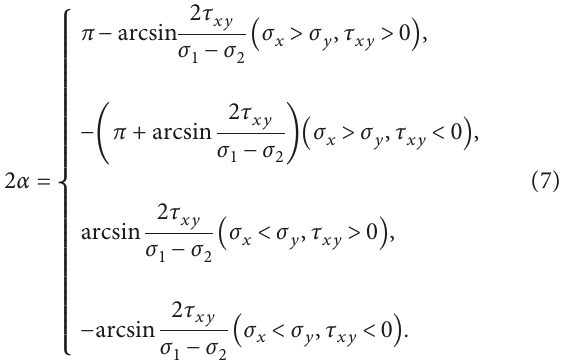
, τ x < σ y x,y > 0. (b) σ x > σ y